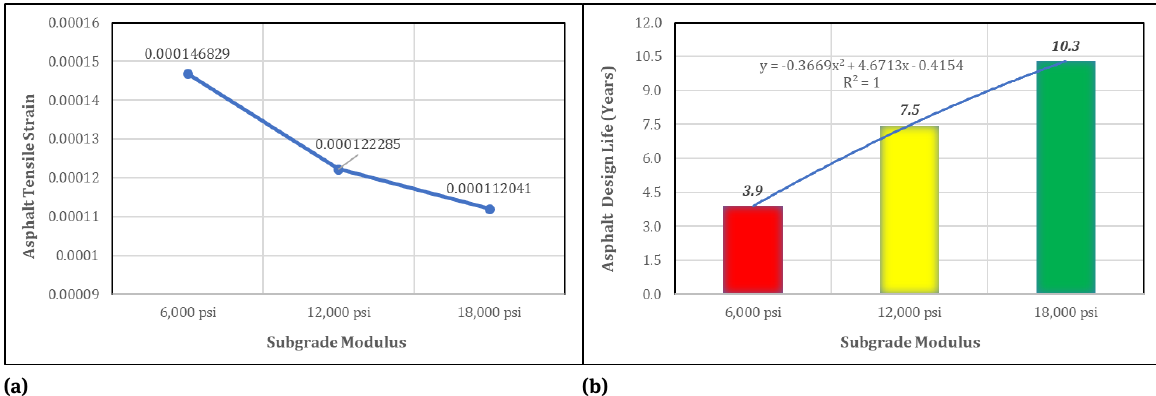
Figure 26: Influence of subgrade modulus on asphalt tensile strain (a) and on asphalt service life (b) in asphaltic overlayment rail